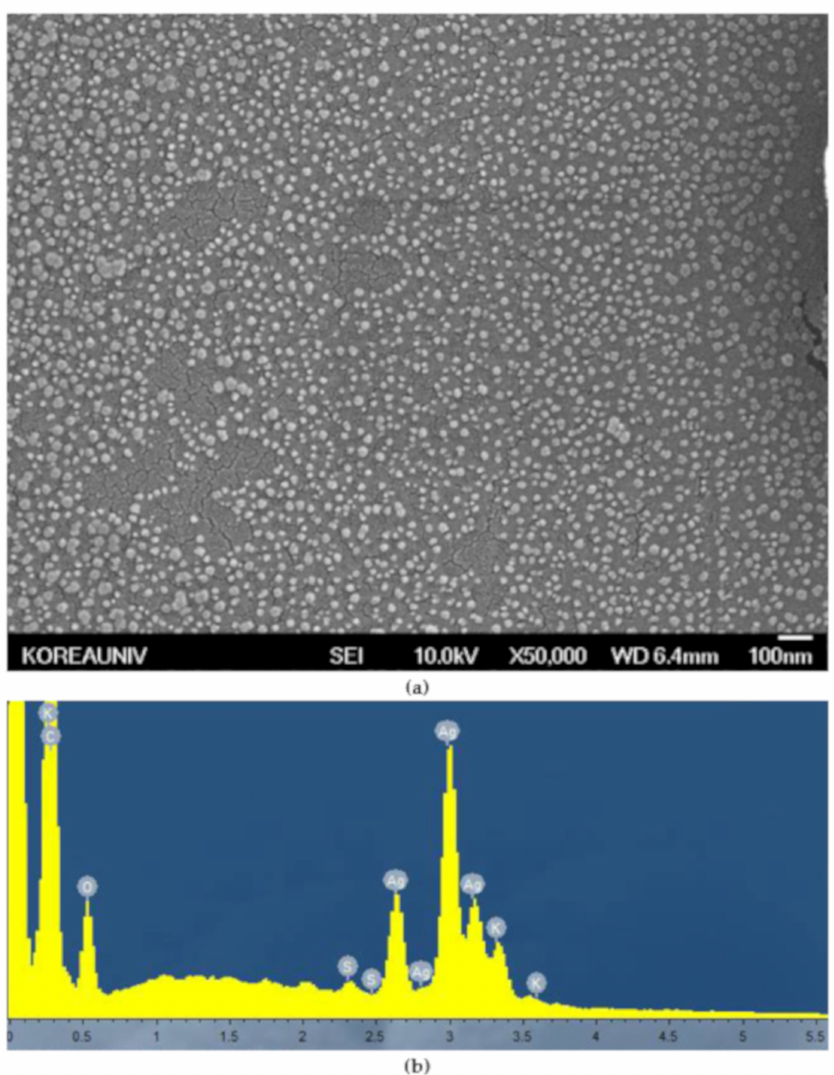
Figure 2. ( a ) Scanning electron microscopy (SEM) image and ( b ) energy dispersive X-ray spectroscopy (EDAX) spectrum of the synthesized silver nanoparticles (AgNPs). Silver nanoparticles were coated with platinum before analysis. The magnification level is 50,000 ×